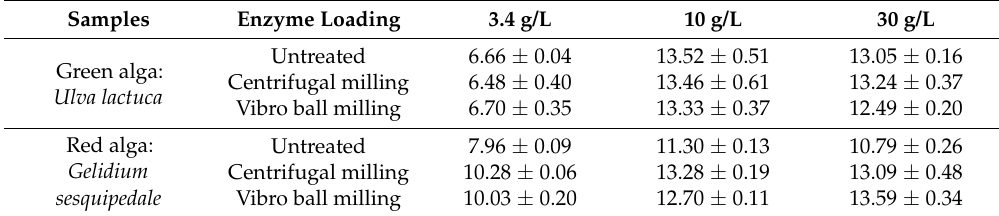
Figure 3. Total sugars released after 72 h of enzymatic hydrolysis for various enzyme dosages (3.4, 10 and 30 g/L) for both untreated ( A ) Ulva lactuca and ( B ) Gelidium sesquipedale . Table 2. Total sugar yields (g/100 g TS) obtained after 72 h of enzymatic hydrolysis of untreated and milled algae with an enzyme dosage of 3.4, 10 and 30 g/L. Samples